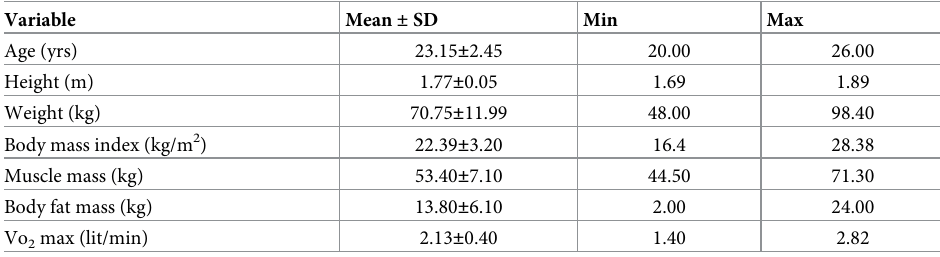
Table 1. Demographic and body characteristics of the participants (n =